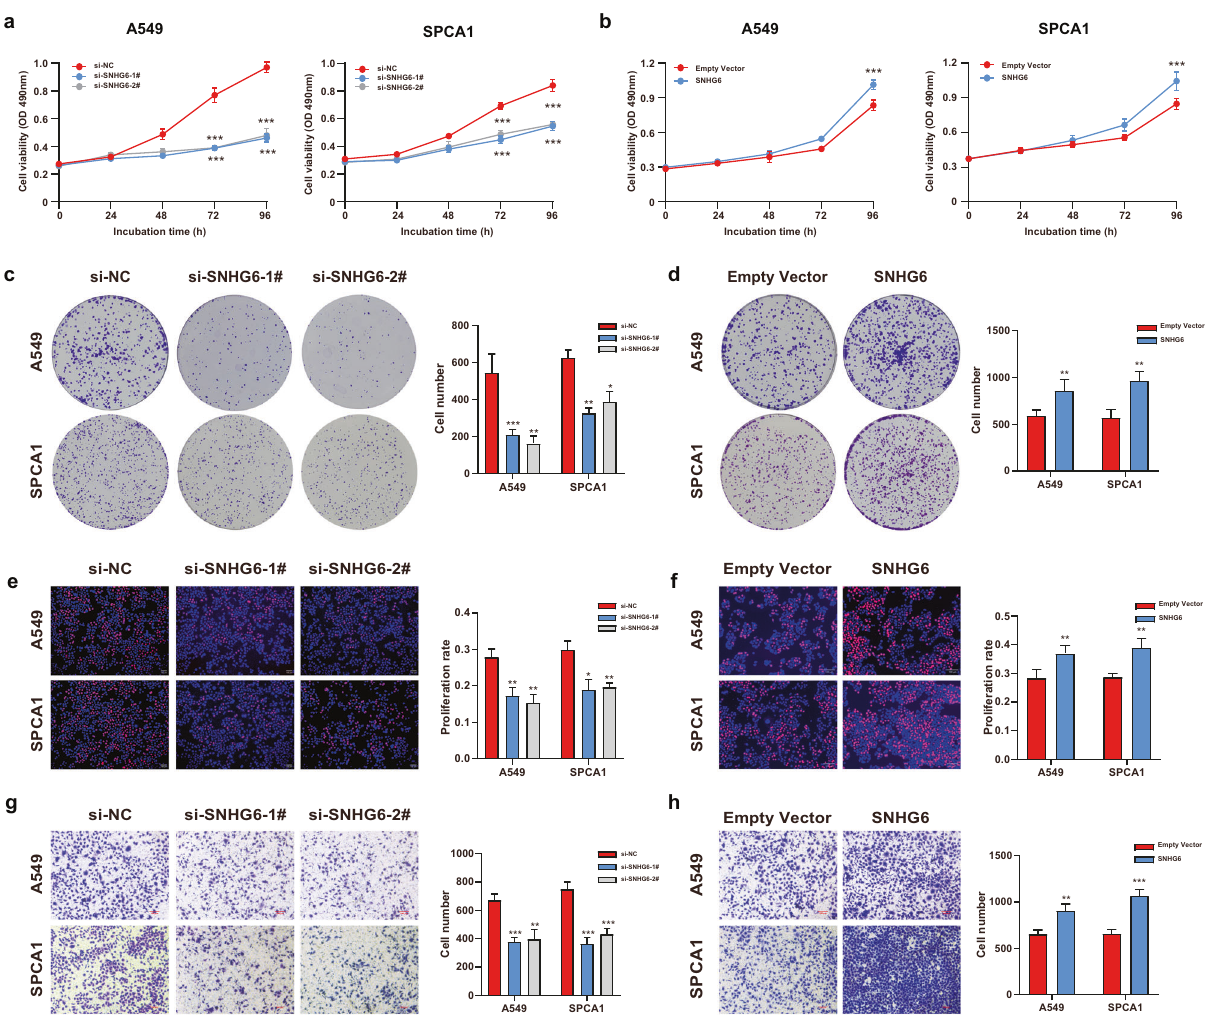
Fig. 2 SNHG6 promoted cell proliferation and migration in NSCLC cell lines. a SNHG6 knockdown weakened the cell viability of A549 and SPCA1 cells; b SNHG6 overexpression increased cell viability of NSCLC cells; c SNHG6 inhibition decreased the formed colonies; d SNHG6 upregulation promoted cell proliferation according to colony-forming assays; e , f The cell proliferation rate of A549 and SPCA1 cells was evaluated using EdU assays after SNHG6 knockdown and overexpression; g SNHG6 silencing inhibited cell migration of A549 and SPCA1; h SNHG6 promoted cell migration of NSCLC cells. The results were from three independent experiments. Data were analyzed by unpaired student ’ s t -test. *** P < 0.001, ** P < 0.01, * P < 0.05. Variables were presented as the mean ± SD. of SNHG6 was signi fi cantly associated with a poorer prognosis of vs 6 tumor tissues). It demonstrated that SNHG6 and UCA1 were NSCLC patients (Fig. 1g, OS: Overall survival, Log-rank P = 0.01). the intersections of high-expressed genes in the two datasets Additionally, we found that SNHG6 expression was positively (Fig. 1b). Mounting evidence has revealed that UCA1 (urothelial correlated with its copy number in NSCLC (Fig. 1h, P < 0.001, cancer associated 1, UCA1) exerted crucial effects on NSCLC r = 0.52, n = 989). The same result was displayed for different copy progression [15 – 18]. Nevertheless, the roles of SNHG6 were largely number alteration groups in Fig. 1i. The fi ndings revealed that the unknown in the tumorigenesis and development of NSCLC. aberrant upregulation of SNHG6 in NSCLC may partially be driven Firstly, we detected the expression level of SNHG6 in pan-cancer by the copy number ampli fi cation of SNHG6. based on the UCSC Xena database (https://xenabrowser.net/ datapages/). As Fig. 1c showed, SNHG6 was signi fi cantly upregu- SNHG6 promoted cell proliferation and migration of NSCLC lated in most malignancies, such as breast invasive carcinoma To explore the biological function of SNHG6, we designed two (BRCA), cholangiocarcinoma (CHOL), colon adenocarcinoma small interfering RNAs (siRNAs) to knock down SNHG6 and (COAD), esophageal carcinoma (ESCA), etc. Especially, SNHG6 constructed the overexpression plasmid to upregulate SNHG6 in was notably upregulated in NSCLC tumor tissues as well (Fig. 1d, NSCLC cells. As Figure S1a showed, the expression of SNHG6 was unpaired samples, Normal = 108 vs Tumor = 1037, P < 0.001; ef fi ciently downregulated after transfection with si-SNHG6, Fig. 1e, 106 paired samples, P < 0.001). In line with the tissue and pcDNA3.1-SNHG6 upregulated SNHG6 expression as well expression, SNHG6 was upregulated in NSCLC cell lines as well (Fig. S1b). The MTT assays, colony formation assays, and EdU (A549, SPCA1, and H1299) compared with the human bronchial assays were carried out to evaluate cell proliferation. The cell epithelial cell line (16HBE) (Fig. 1f). A549 and SPCA1 were the cell viability of A549 and SPCA1 was inhibited after SNHG6 knockdown lines with the highest SNHG6 expression, and they were chosen (Fig. 2a). Inversely, transfection with pcDNA3.1-SNHG6 signi fi cantly for the subsequent experiments. Furthermore, the high expression Cell Death Discovery (2022)